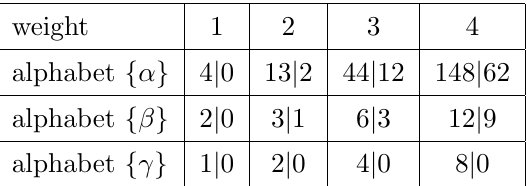
Table 1 . Number of parity even j odd integrable symbols up to weight four for the ten-letter f (cid:11) g (3.6), (cid:12)ve-letter f (cid:12) g (3.10), and two-letter f (cid:13) g alphabets satisfying the (cid:12)rst entry